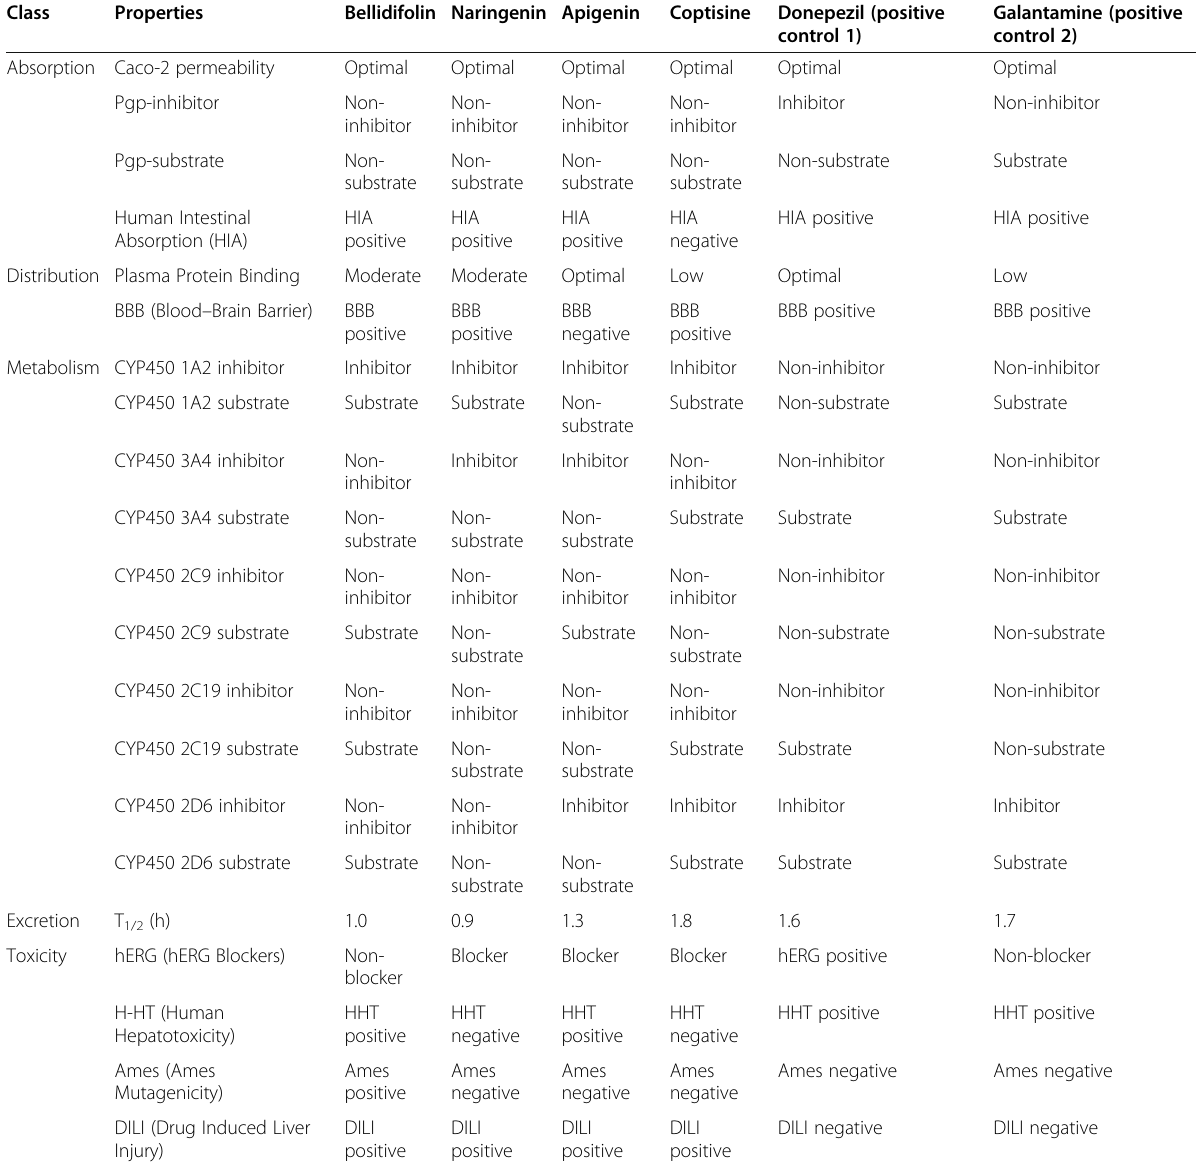
Table 6 The ADME/T test results of the best 4 ligand molecules along with the two positive controls